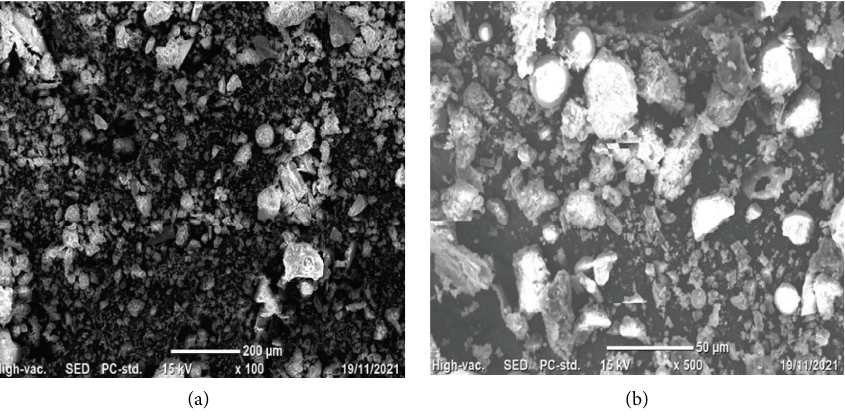
Figure 7: SEM picture of expansive soil.